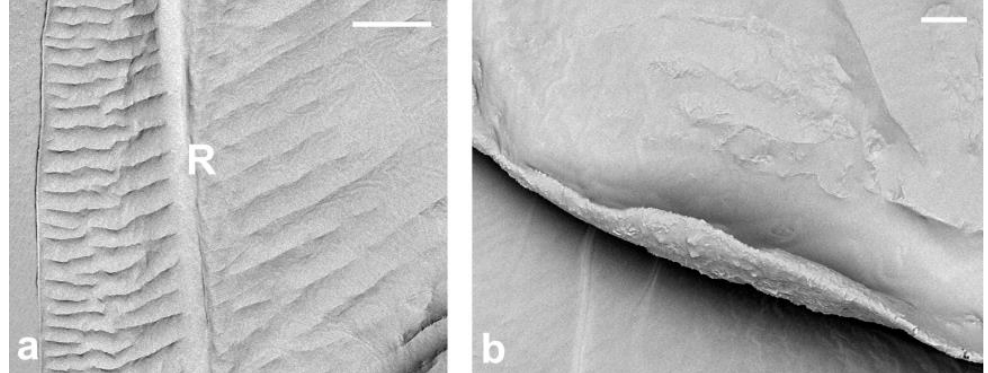
Figure 2. Wings of M. pini ; ( a ) sculpture of the dorsal side of the wing membrane; ( b ) fold of the anal lobe. Scale bar ( a ) 50 μm; R—Radius. ( b ) 10 μm.